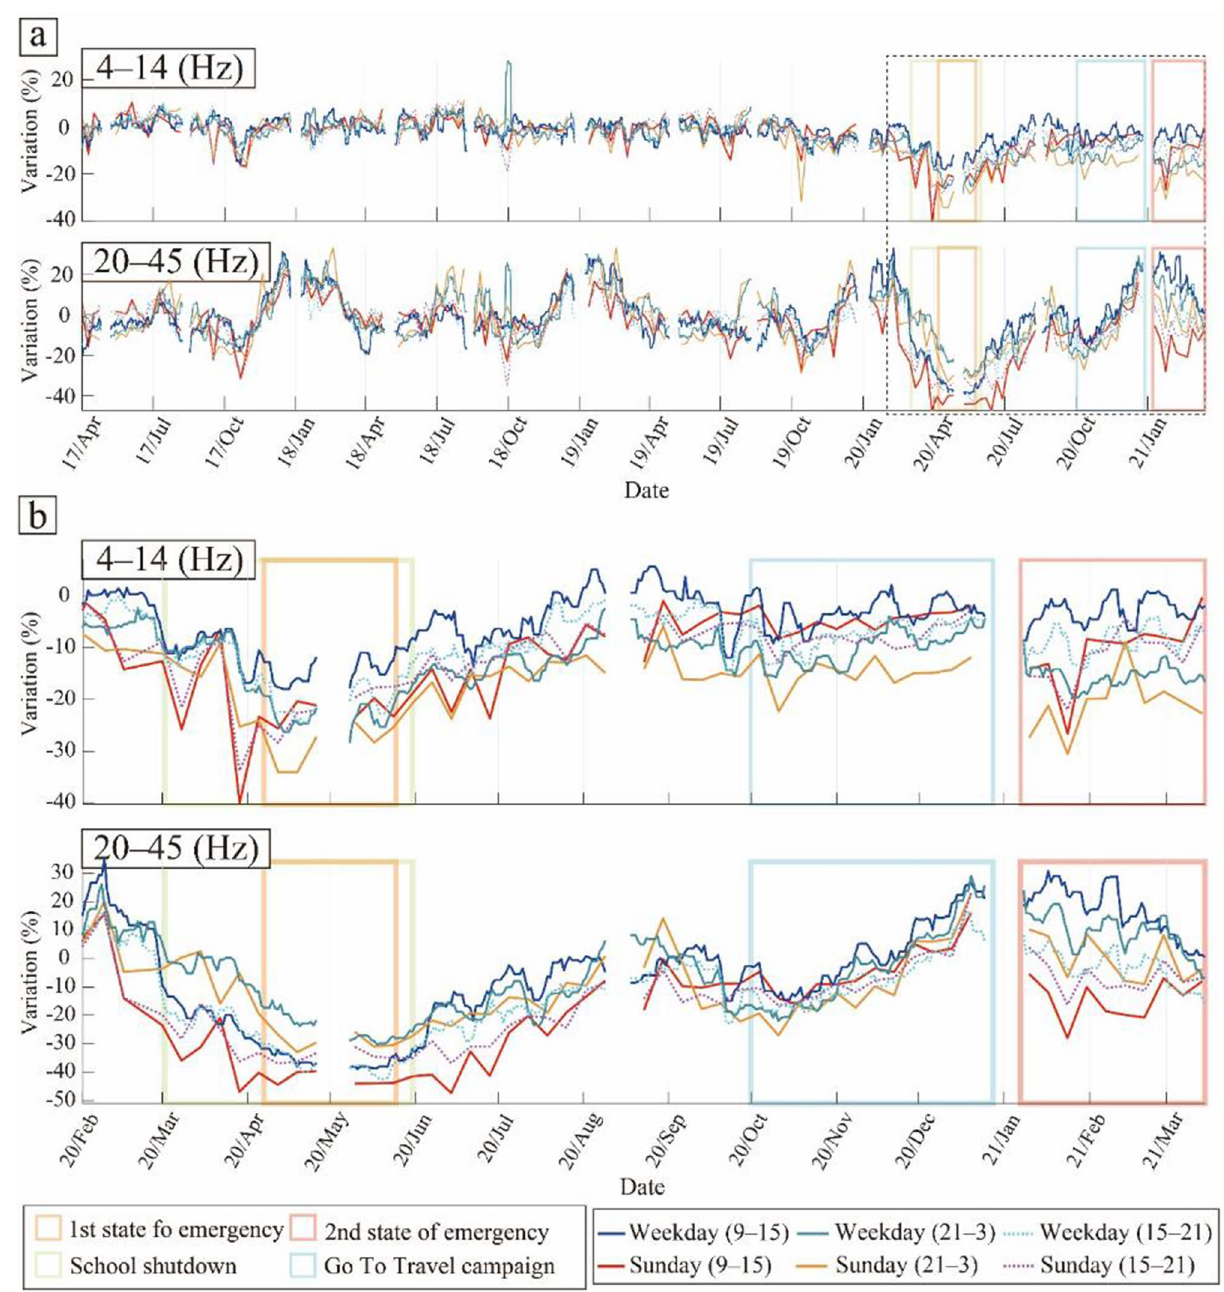
Figure 5. Temporal variations of PSD depending on the day of the week. ( a ) From April 2017 to March 2020. ( b ) Enlarged view of the black dashed square in ( a ). Each solid line indicates the PSD under each condition shown in the right bottom box. The orange and pink squares represent the periods of first and second states of emergency in Tokyo, respectively; the green square represents the period of school closures; and the light blue square represents the period of the Go To Travel